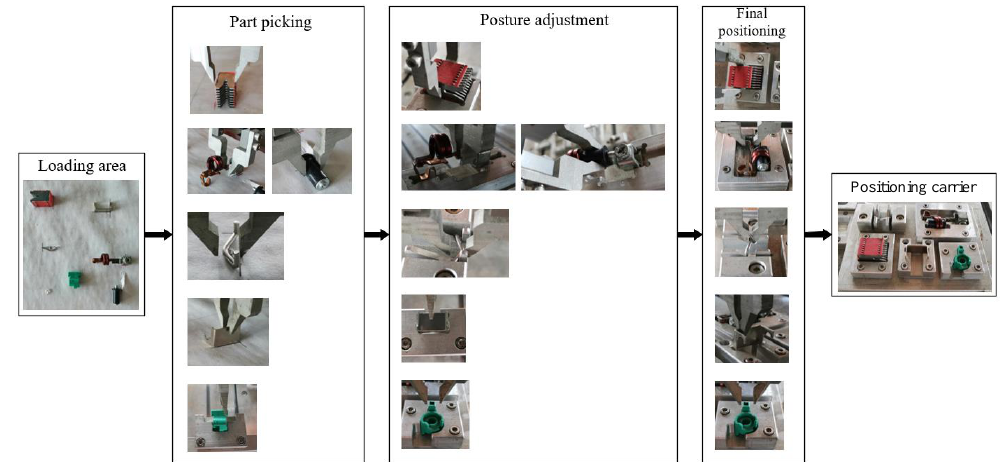
Figure 16. Flexible assembly experiment.